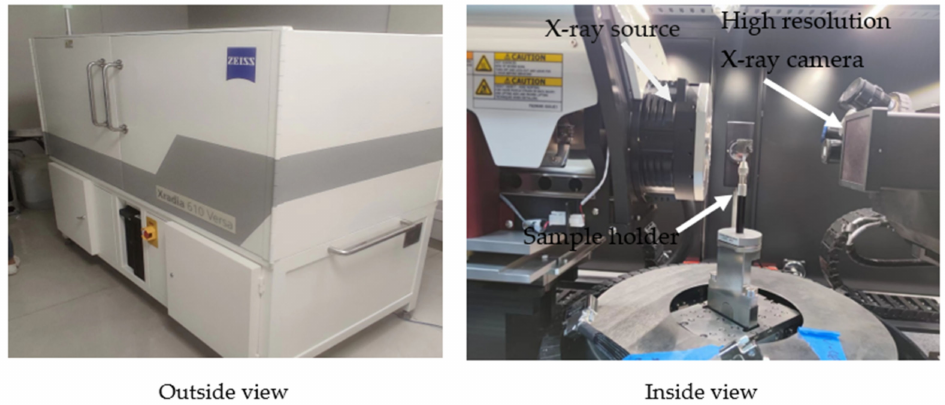
Figure 3. X-ray computed tomography machine.